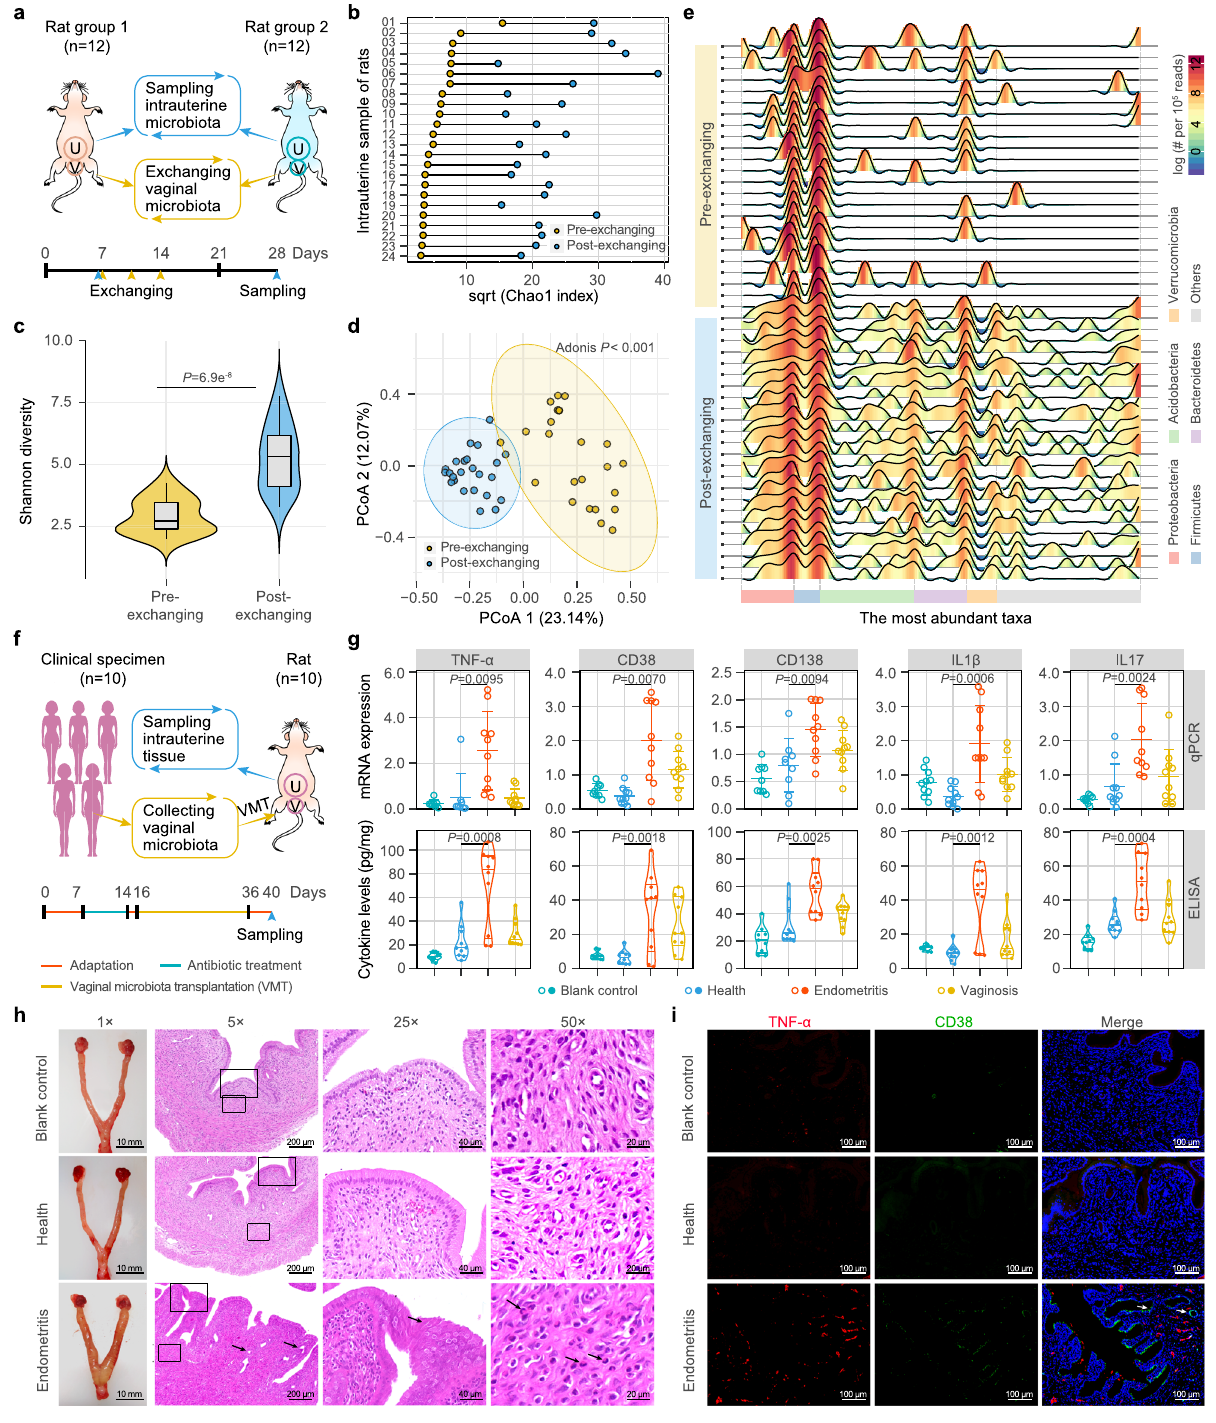
with bacterial vaginosis and transplanted their vaginal lavage fl uids into the vaginas of SD rats ( n = 10) that had previously been submitted to 1 week of antibiotic treatment. After transplantation once a day for 3 weeks, qPCR and ELISA were performed to measure the in fl ammatory factors, and the changes in uterine morphology and tissue were also examined (Fig.